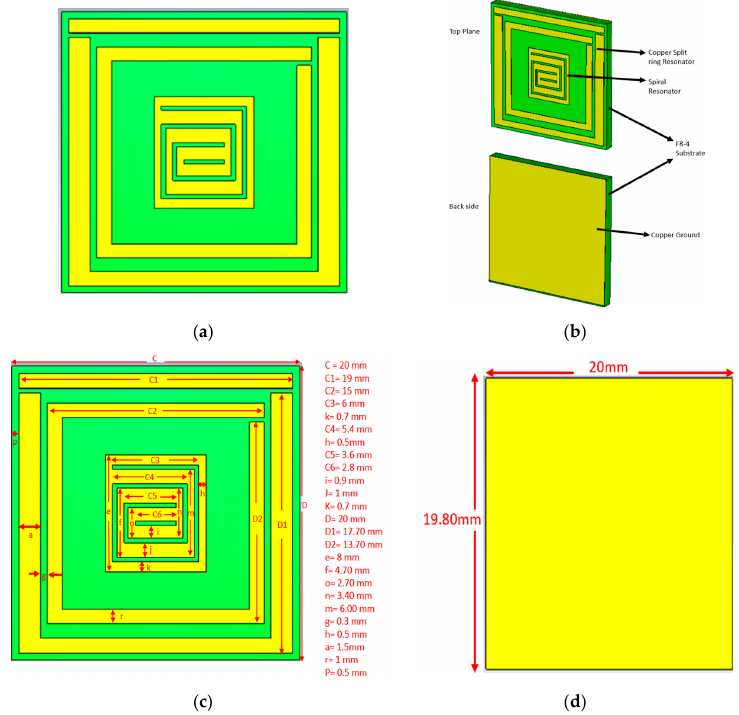
Figure 1. The proposed unit cell. ( a ) Split-ring resonator with a rectangular snake-cutting structure. ( b ) The complete construction of the MA. ( c ) All of the copper parameters. ( d ) The ground.